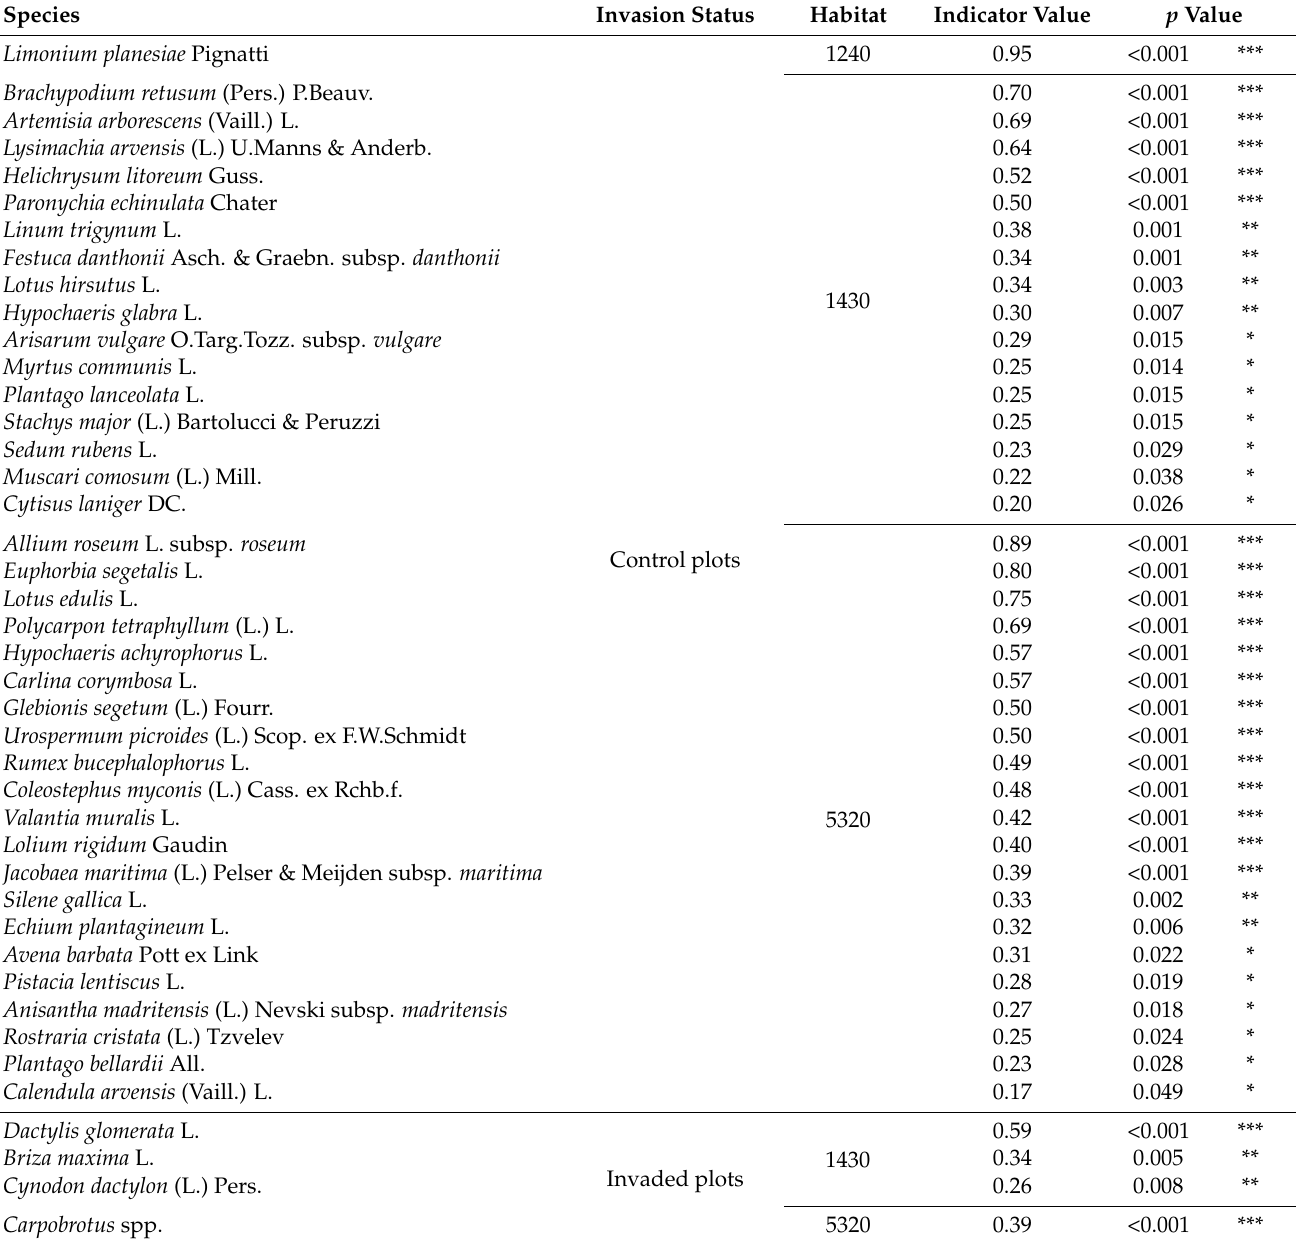
Table 2. Results of the Indicator Species Analysis according to N2000 habitat and invasion status (Control plots vs. Invaded plots). N2000 habitat codes: 1240 = vegetated sea cliffs of the Mediter- ranean coasts with endemic Limonium spp., 1430 = Halo-nitrophilous scrubs ( Pegano - Salsoletea ) and 5320 = Low formations of Euphorbia close to cliffs. Significance codes: p value < 0.001